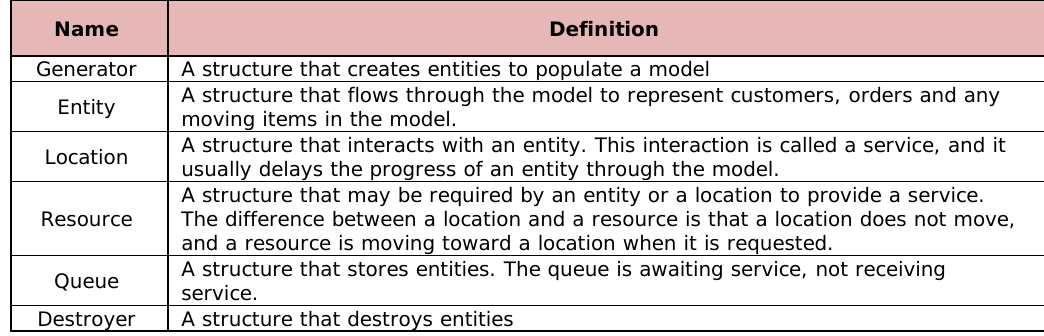
Table 2. “Basic simulation objects and